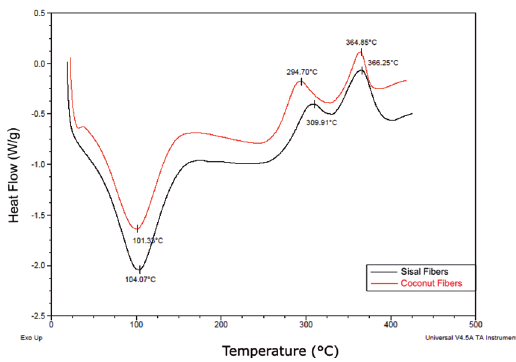
Figure 1: DSC curve of sisal and coconut fibers